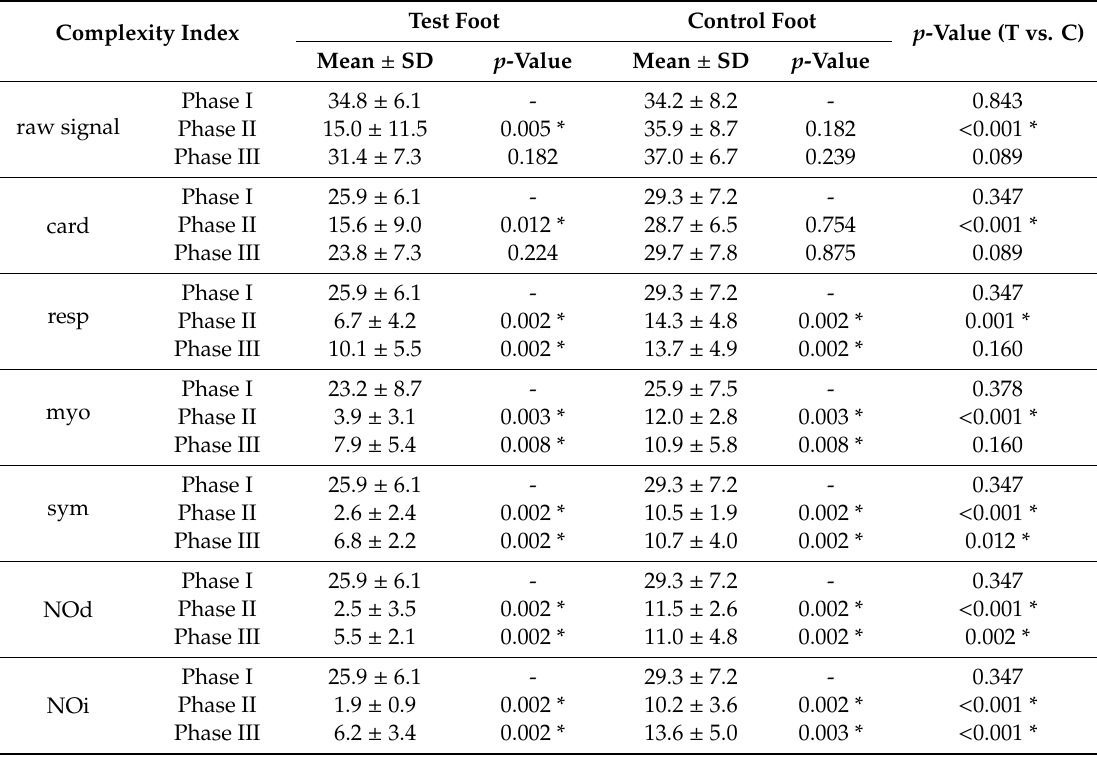
Table 1. Mean and standard deviation (SD) of the MSE complexity index for each foot on each phase of the protocol (card—cardiac, resp—respiratory, myo—myogenic, sym—sympathetic, NOd—endothelial NO-dependent, NOi—endothelial NO-independent). Statistical comparison to Phase I is shown (*— p <